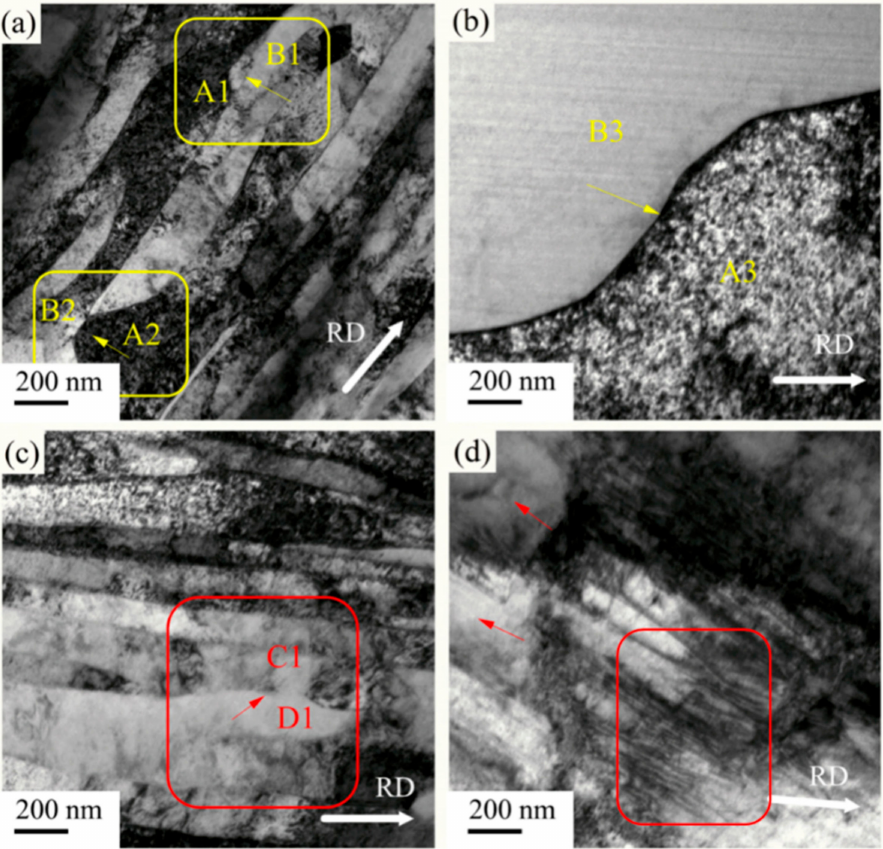
Figure 6. TEM images of the recrystallization behavior of Ni sheets subjected to room-temperature rolling with subsequent annealing at ( a ) 160 ◦ C and ( b ) 240 ◦ C, and cryorolling with subsequent annealing at ( c ) 160 ◦ C and ( d ) 240 ◦